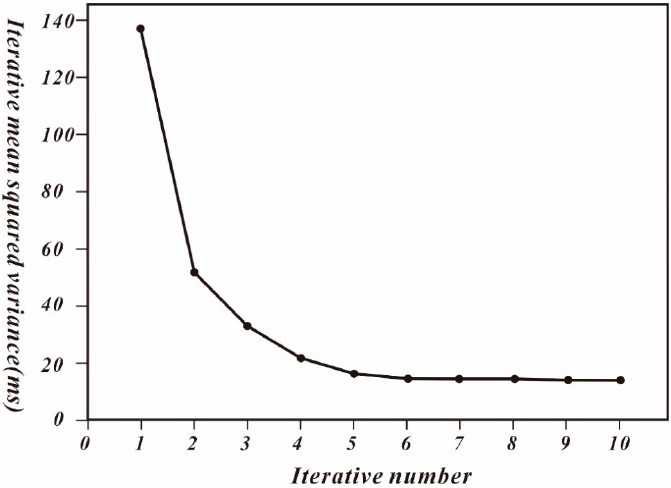
Figure 6. Iterative convergence curves of the tomographic inversion. As shown in Figure 7, the actual first-arrival times (i.e., the picked first-arrivals times, shown by the red part of Figure 7A) and the theoretical first-arrival times (i.e., the first-arrival times calculated by inversion, shown by the blue part of Figure 7B) were superimposed and displayed in a full-alignment manner. Preliminary inspection indicated that the first-arrival times calculated by inversion were in good accordance with the actual times, indicating that the inversion results and are in good agreement with those of the actual model.